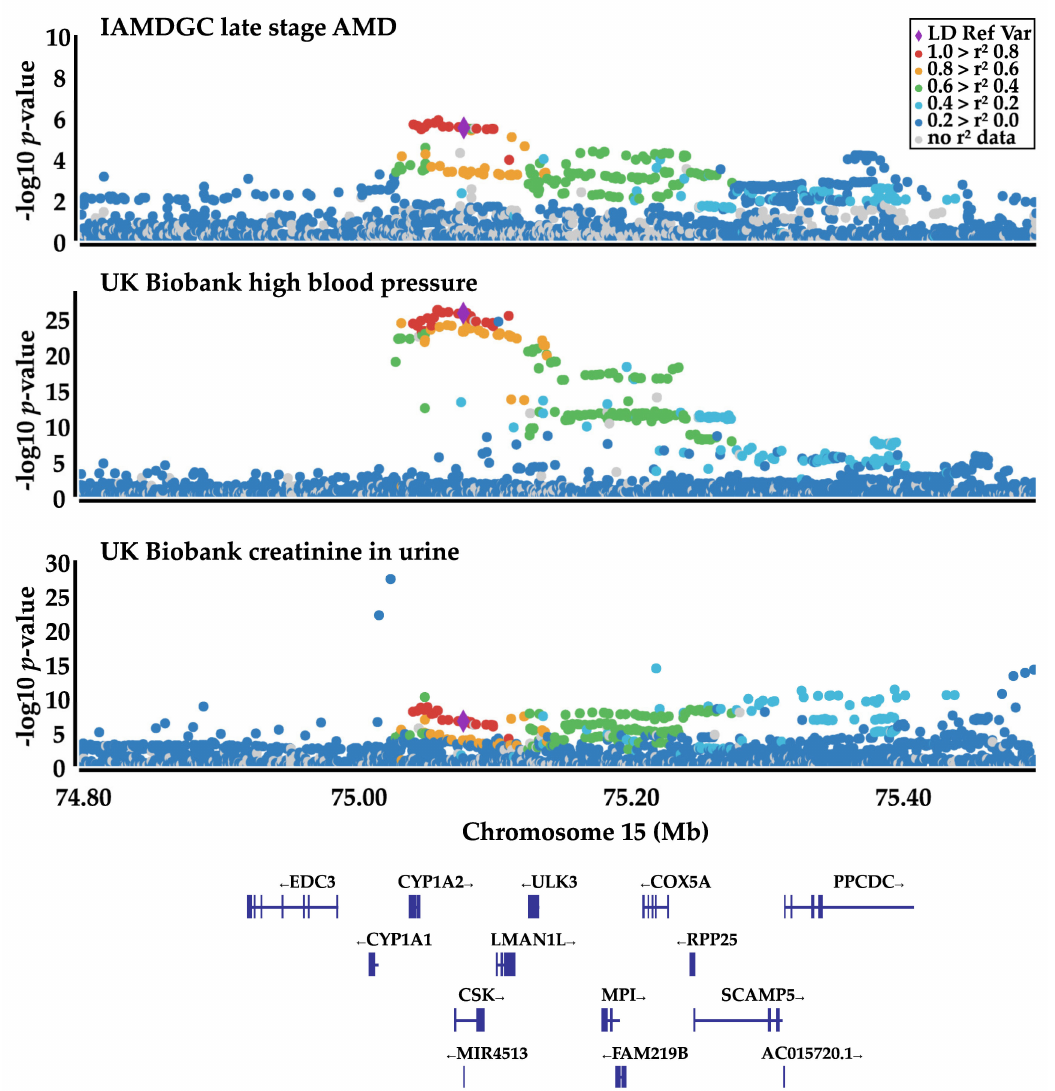
Figure 3. Locuszoom plots of the association signals in late-stage AMD (IAMDGC), “Vascular / heart problems diagnosed by doctor: High blood pressure” (UK Biobank) and “Creatinine in urine” (UK Biobank). The genetic association signal of AMD represents the same genetic signal as for the blood pressure association (coloc probability = 0.976), while the “UKB creatinine in urine” association underlies a di ff erent genetic signal (coloc probability = 0.037). Rs2168518 is presented as a purple diamond and serves as LD reference variant. Plots were created with Locuszoom [30]. This is the case for most of the phenotypes in all sub-studies (both sexes, as well as female and male) in comparison with AMD (both sexes and male). Exceptions are DBP and SBP, which